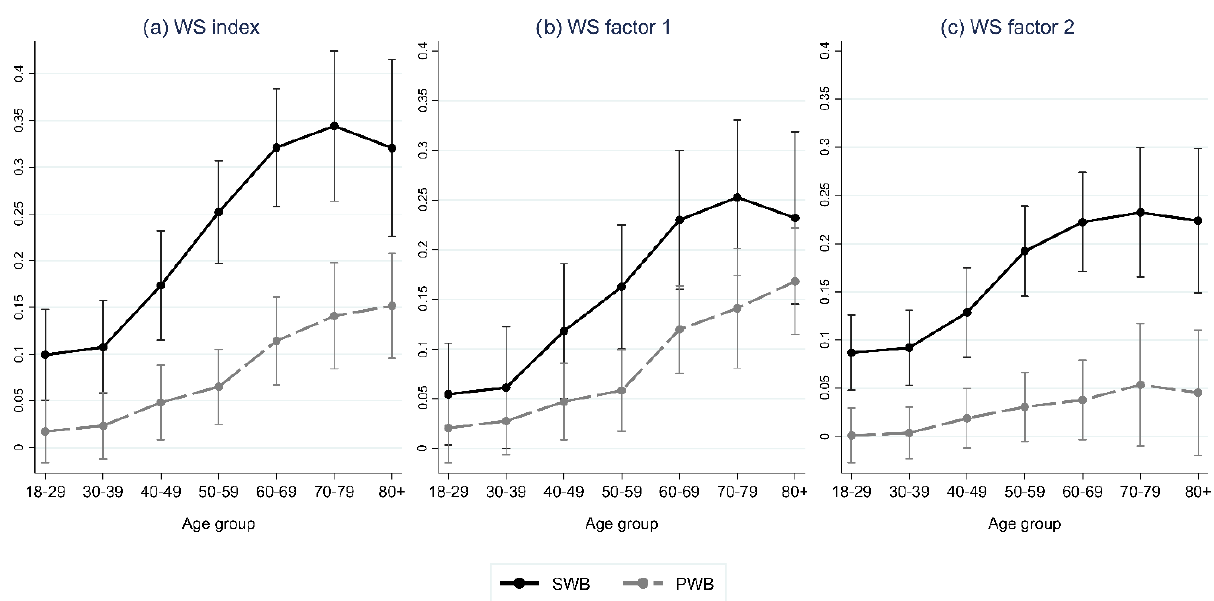
Figure 2. Results from multilevel regression of subjective wellbeing (SWB) and psychological well- being (PWB). Marginal effects of WS index from Model 1 ( a ), WS factor 1 ( b ) and WS factor 2 ( c ) from Model 2, by age group.